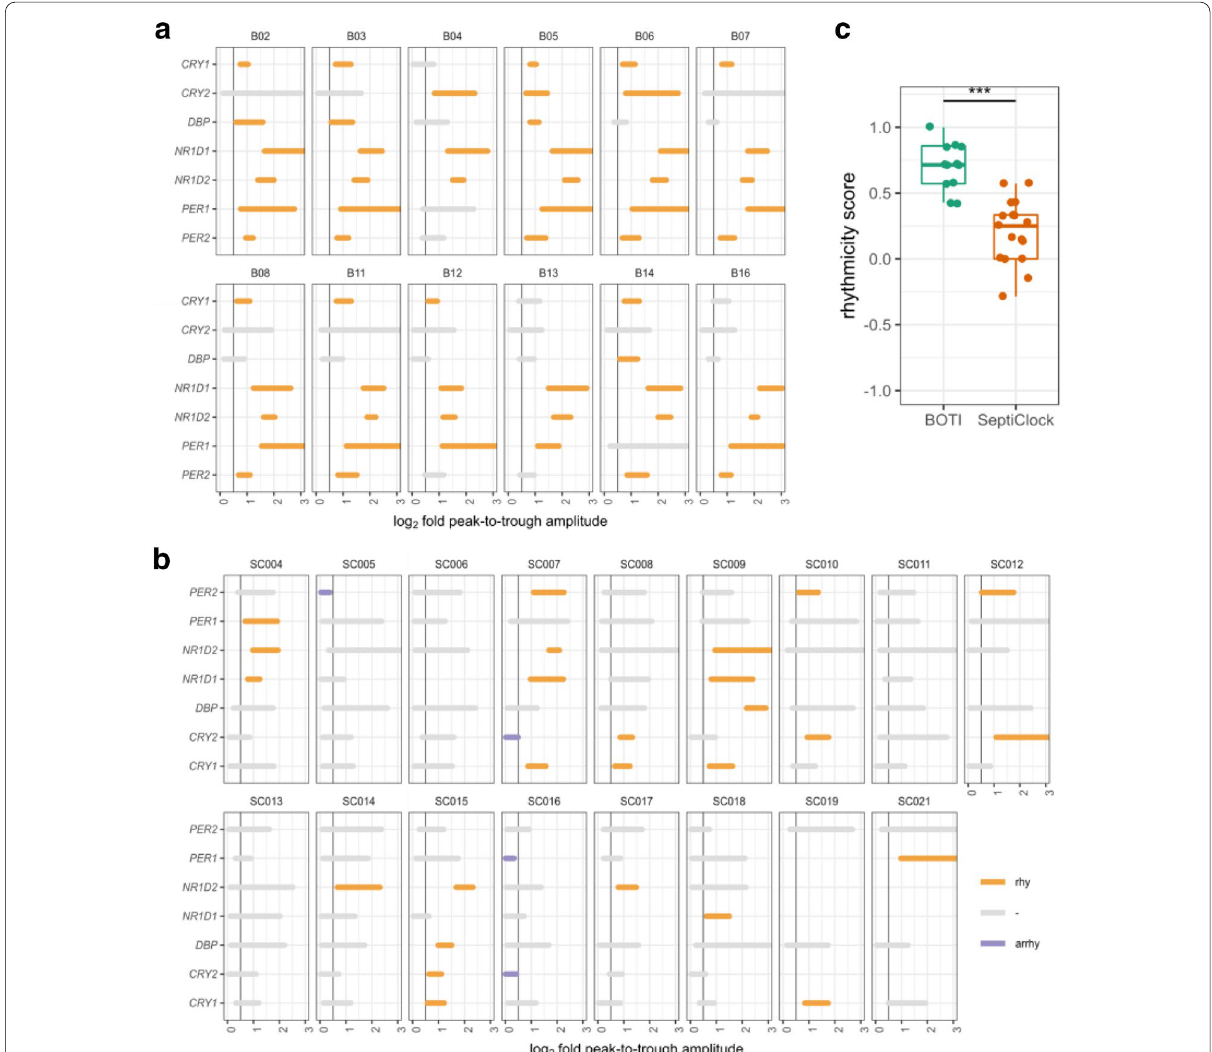
Fig. 6 Comparison of rhythmicity of common clock genes between septic shock patients and healthy young men. a The confidence intervals (CI) for the clock genes from BOTI subjects used to classify clock genes as rhythmic, arrhythmic or inconclusive (similar to Fig. 2). b The confidence intervals for the common clock genes in septic shock patients extracted from Fig. 2 for comparison with ( a ). c The comparison of the rhythmicity scores between septic shock patients and healthy young adults based on the classification in ( a , b ). The scores were compared using a non‑parametric Wilcoxon rank‑sum